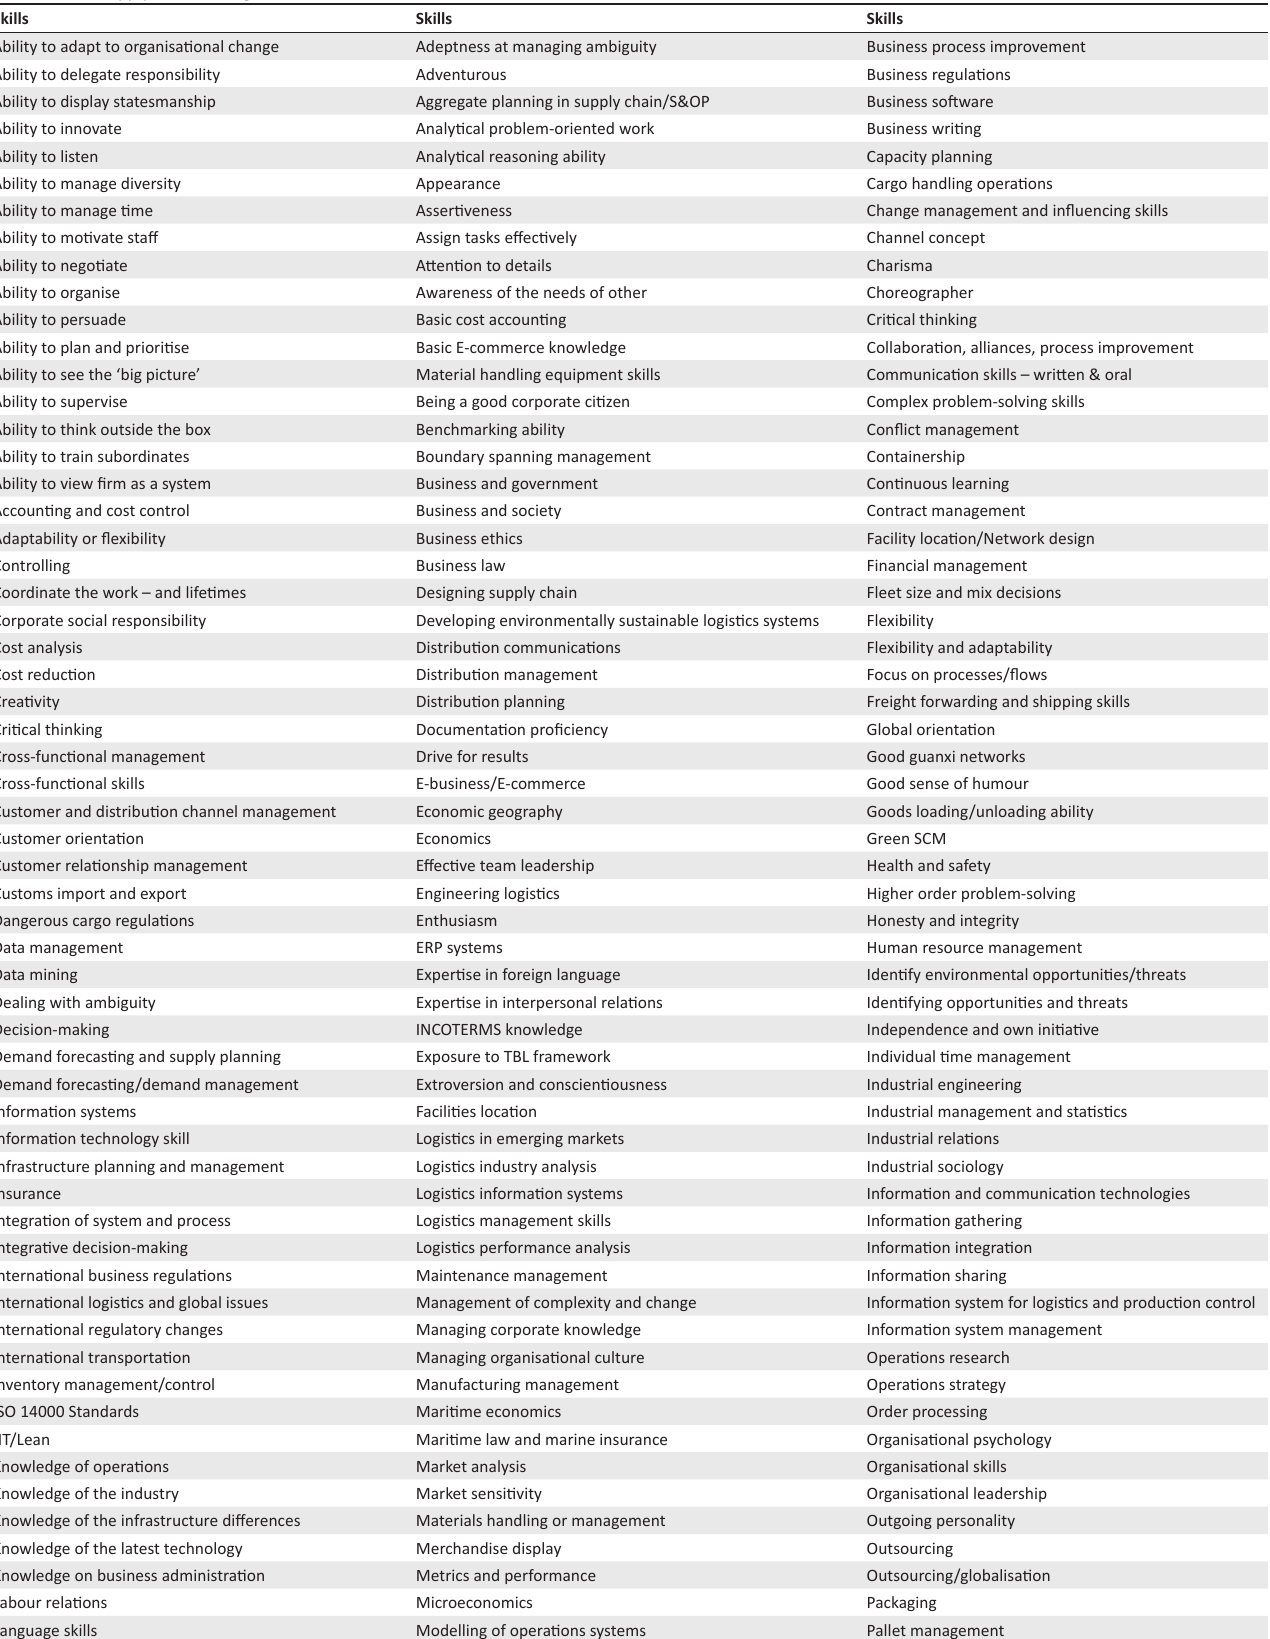
FIGURE 1-A1: Supply chain management skills.